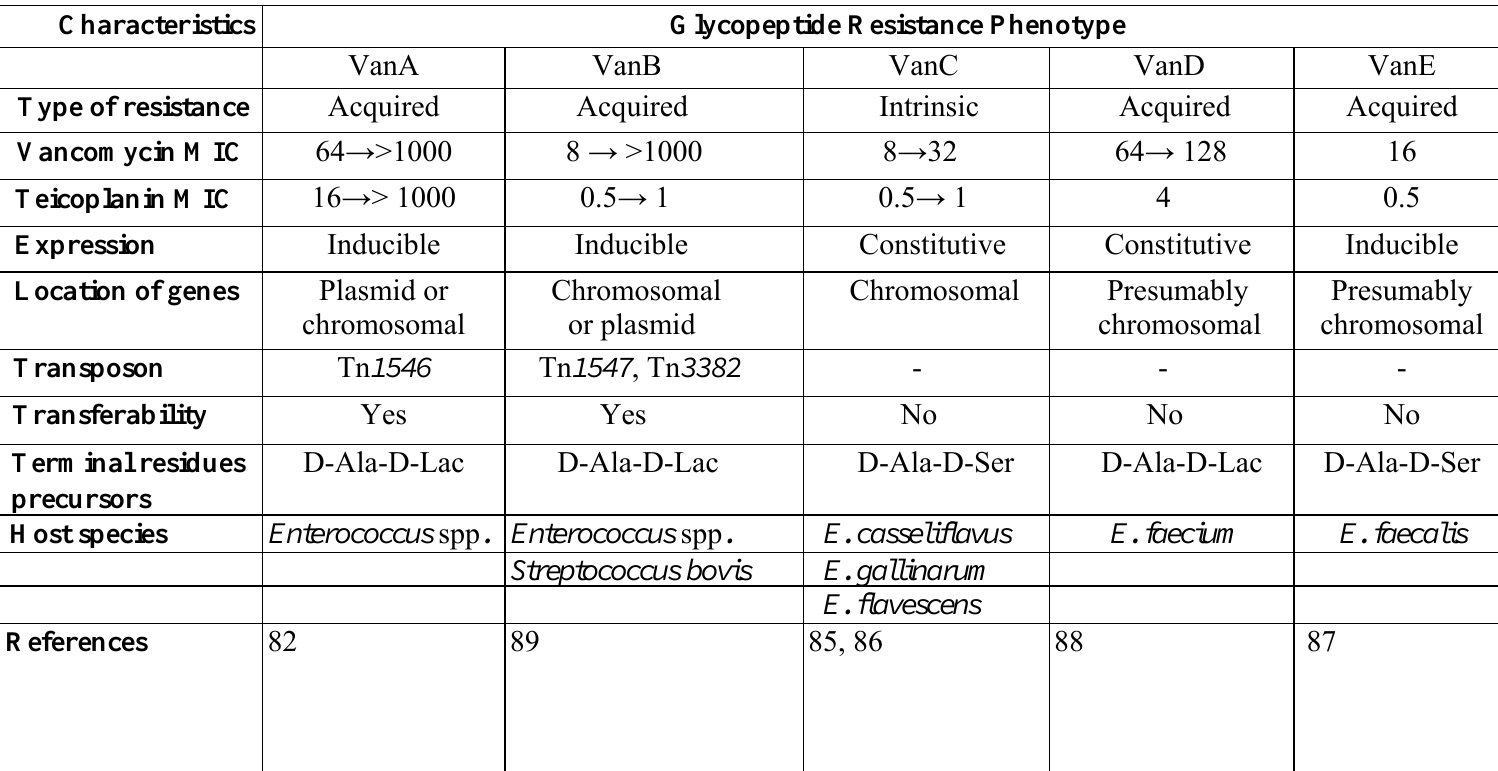
Table 3. Characteristics of the glycopeptide resistance phenotypes in